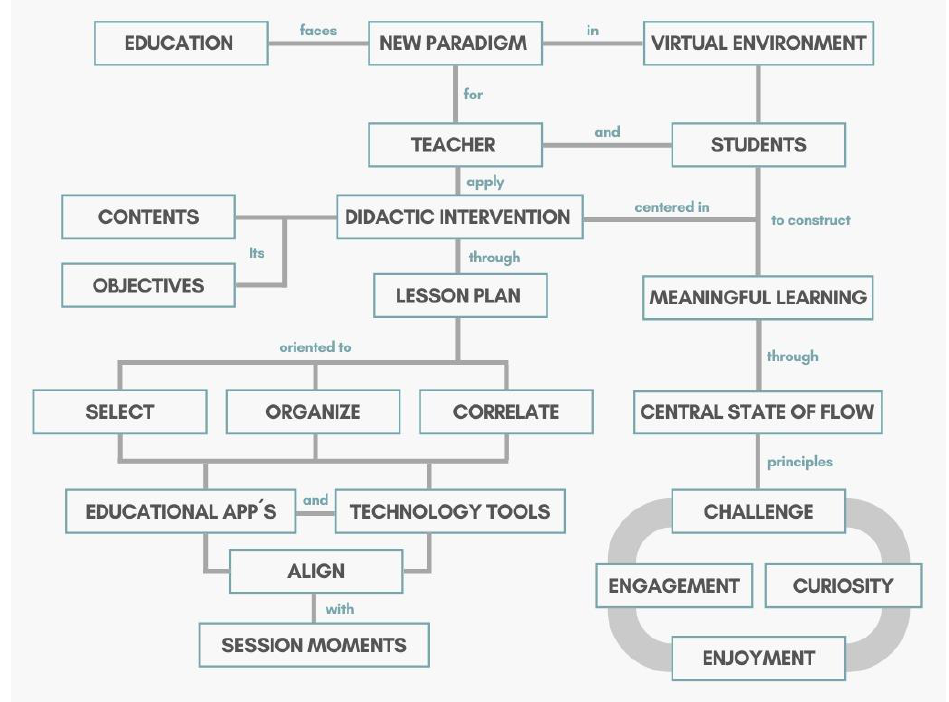
Figure 1. Relation of theoretical and conceptual elements that define an interpretative and design frame of reference in this research. frame of reference in this